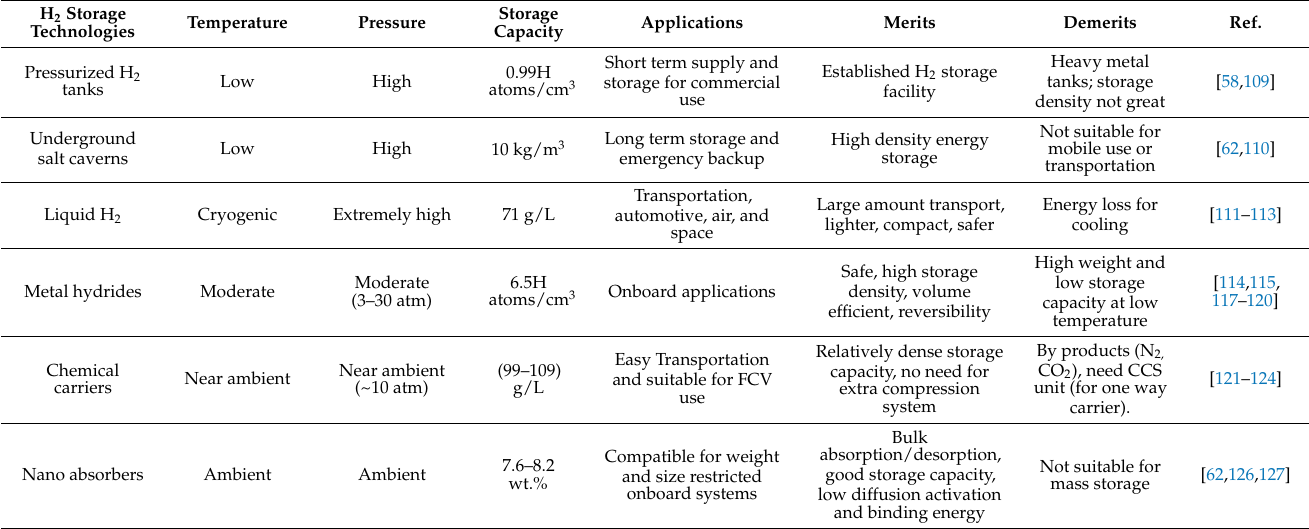
Table 2. Comparison among different H 2 storage